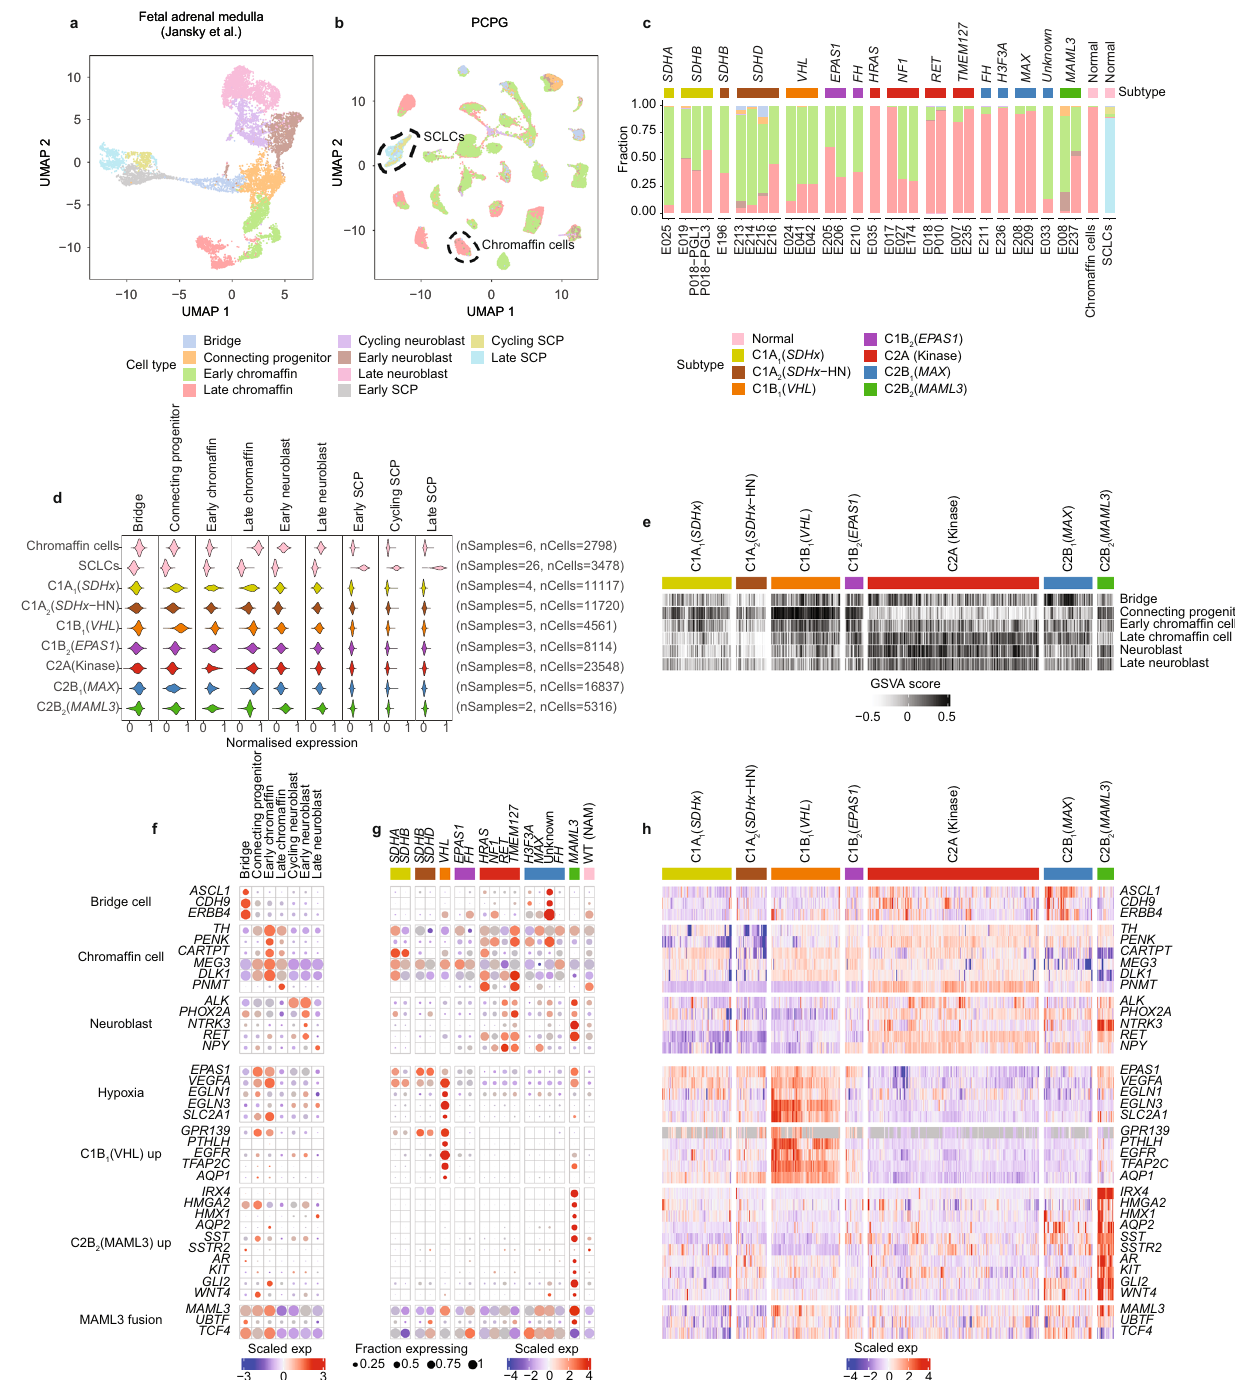
Fig. 6 | Comparison of expression pro fi le of PCPG neoplastic cells to normal fetaladrenalcelltypes.a ,UMAPprojectionillustratingsnRNA-seqoffetaladrenal medulla (nSamples =17, nCells = 10,739), previously published by Jansky et al. 49 . b UMAP of PCPG cell populations colored by their cell type classi fi cation (nSam- ples =30, nNeoplastic cells = 81,213, nSCLCs = 3335) and adult adrenal medulla (nSamples =2, nChromaf fi n cells = 2798, nSCLCs = 143). The black dotted lines shownormalchromaf fi nandSCLCcelltypes. c ProportionNEOcellsornormalcells (PCPG and NAM combined) classi fi ed as normal fetal adrenal cell types. d snRNA-